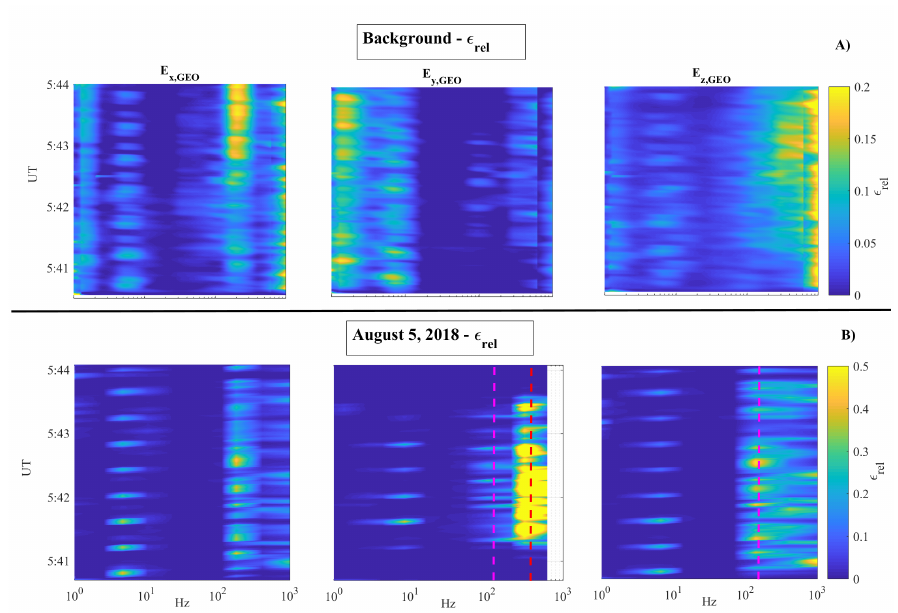
Figure 7. CSES satellite Electric Field detector observations. Box ( A ) Environmental background evaluated over the earthquake epicenter in terms of ¯ (cid:101) rel vs. time and frequency for the reference quiet condition ( M ≤ 2; Sym-H = [10 nT, − 10 nT]; AE < 100 nT) for the three components of the electric field; Box ( B ) (cid:101) rel evaluated over the earthquake epicenter on 5 August 2018 for the three components of the electric field. Magenta and red vertical dashed lines represent anomalous peaks at ∼ 180 Hz and at ∼ 630, respectively. Colors are representative of the (cid:101) rel values.